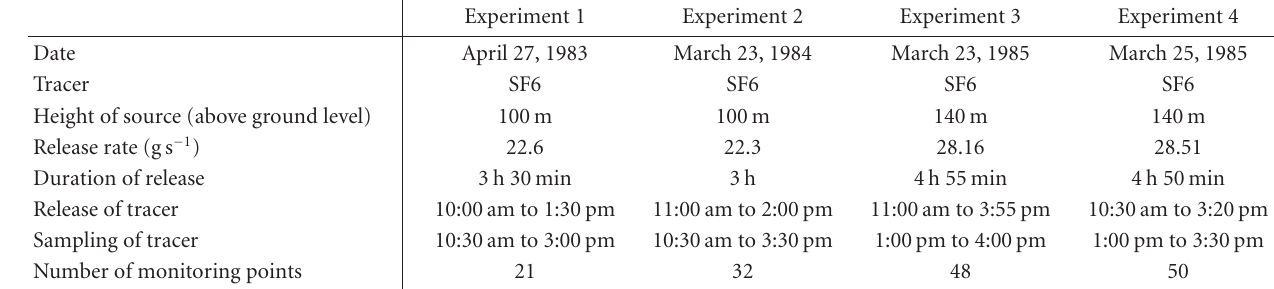
Table 1: Characteristics of the tracer